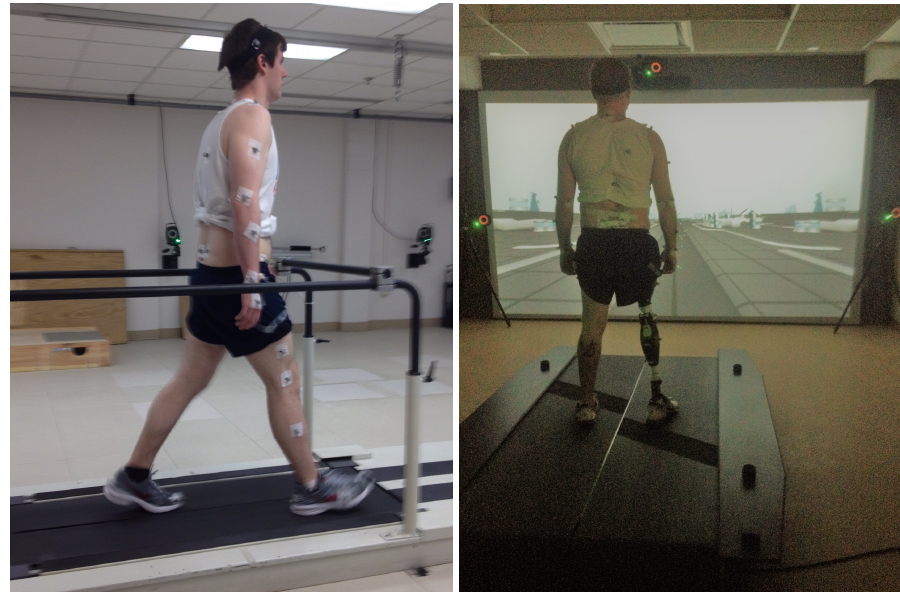
Figure 2. Experimental setup for data collection. The left figure shows an able-bodied subject and the right figure shows an amputee subject with an Ottobock prosthesis on the right leg.